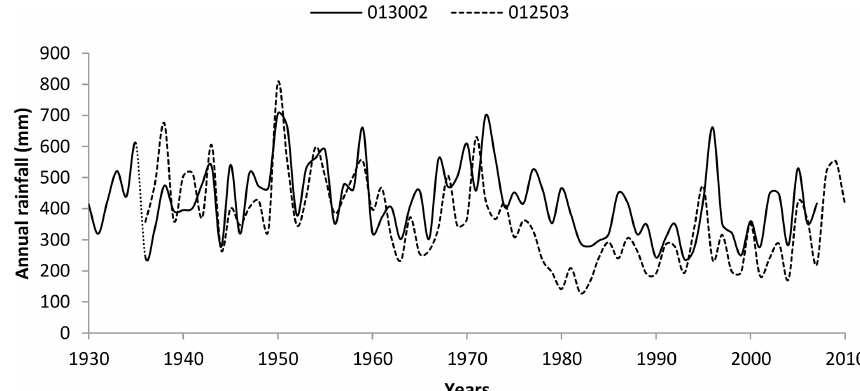
Figure 3. Evolution of rainfall in the stations 013002 and 012503.